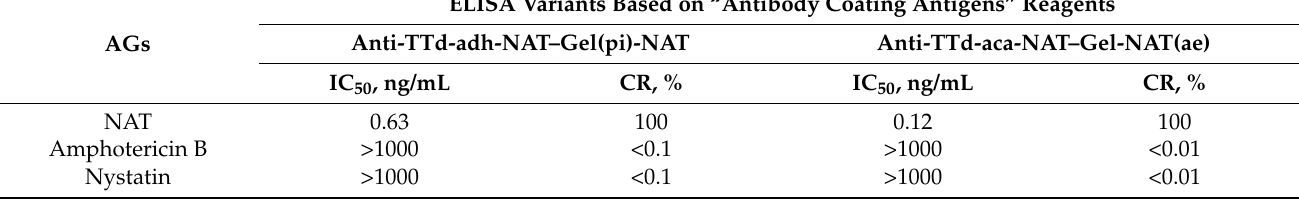
Table 1. Specificity of two selected ELISA